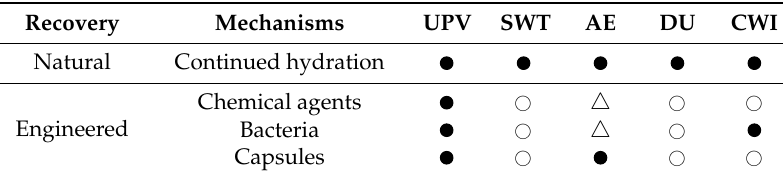
Table 6. Appropriate self-healing